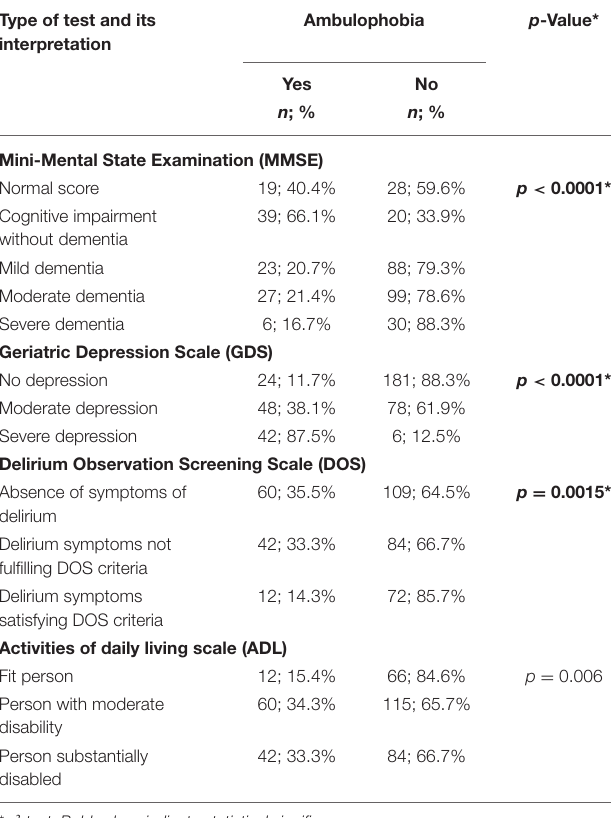
TABLE 2 | Occurrence of ambulophobia among patients with diagnosed selected diseases. Disease entity